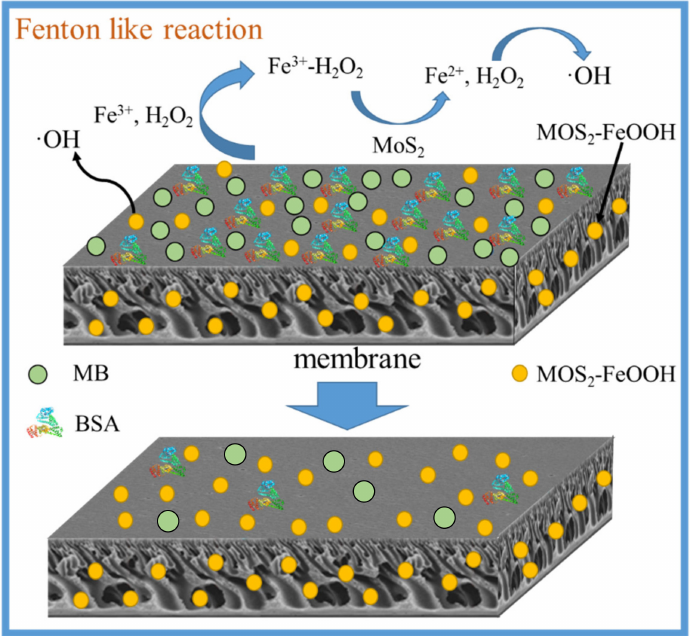
Figure 9. Schematic illustration of the catalytic self-cleaning